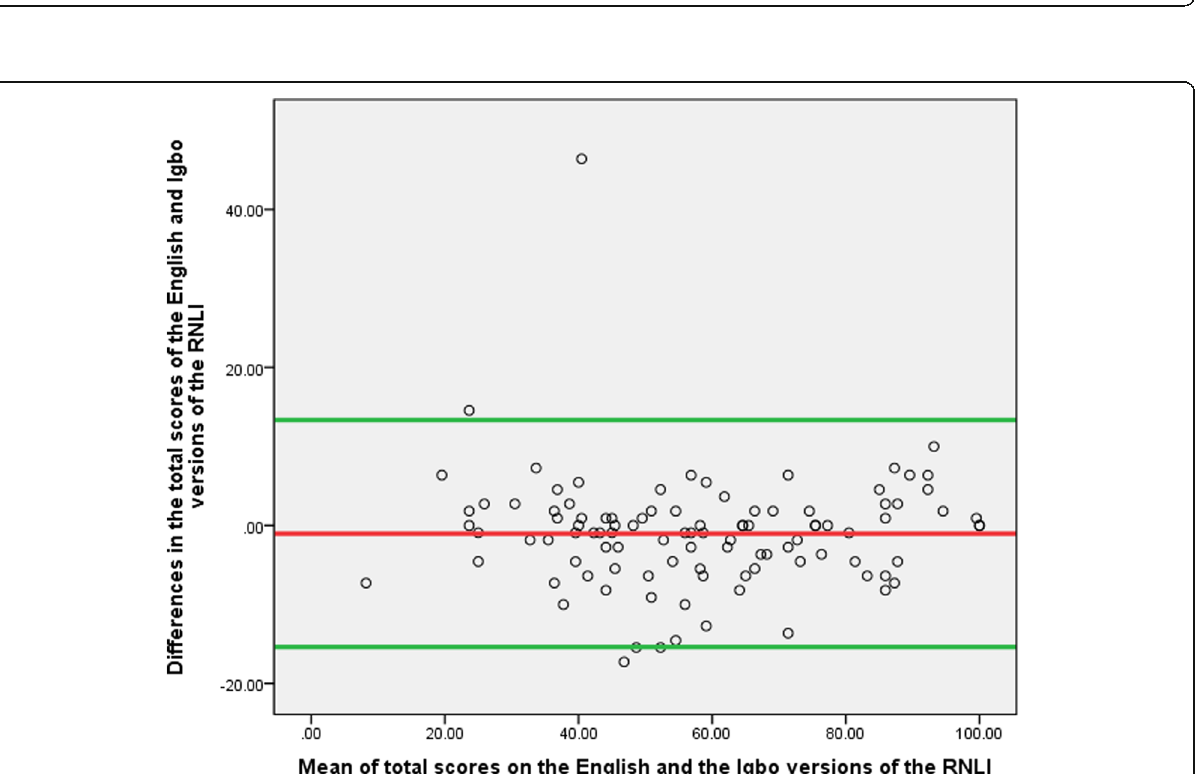
Fig. 4 Bland-Altman plot of the total scores on the the E-RNLI and the I-RNLI. KEY : I-RNLI = Igbo version of Reintegration to Normal Living Index. E-RNLI = English version of Reintegration to Normal Living